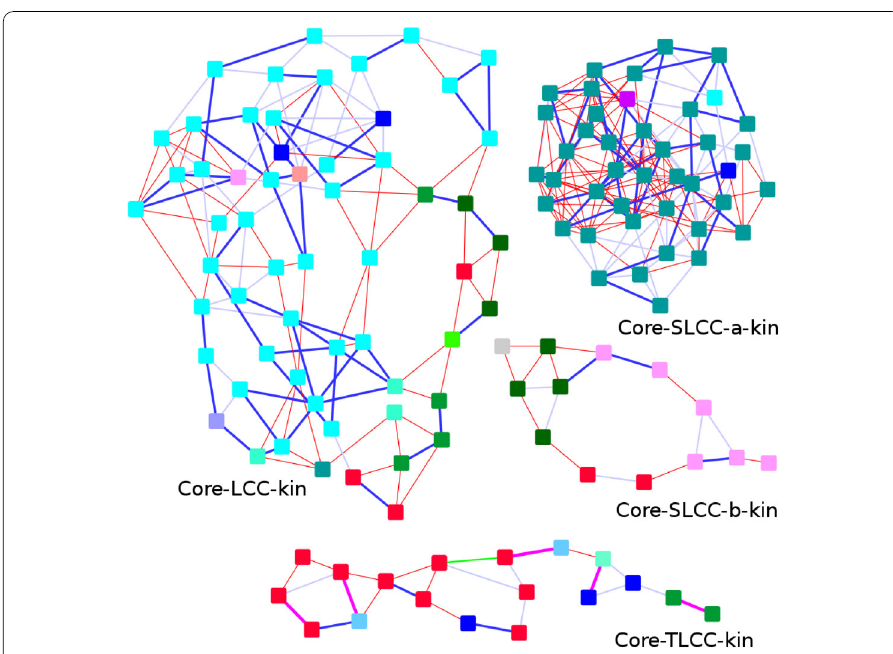
Figure 6 Network of kins. The subnetworks represent patterns of connection between individuals who are horizontal kin and are extracted from the network of families illustrated in Fig. 5. Each node in the above subgraphs is an individual (offspring) resulting from a link (parental union) in the subnetworks in Fig. 5. The colour of a node represents the birth region of the individual. The colour of a link indicates the nature